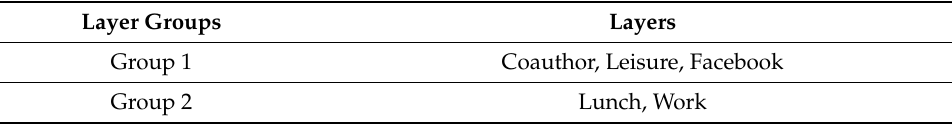
Table 3. Between-layer clustering results obtained by MFSE on AU-CS network. Layer Groups Group 1